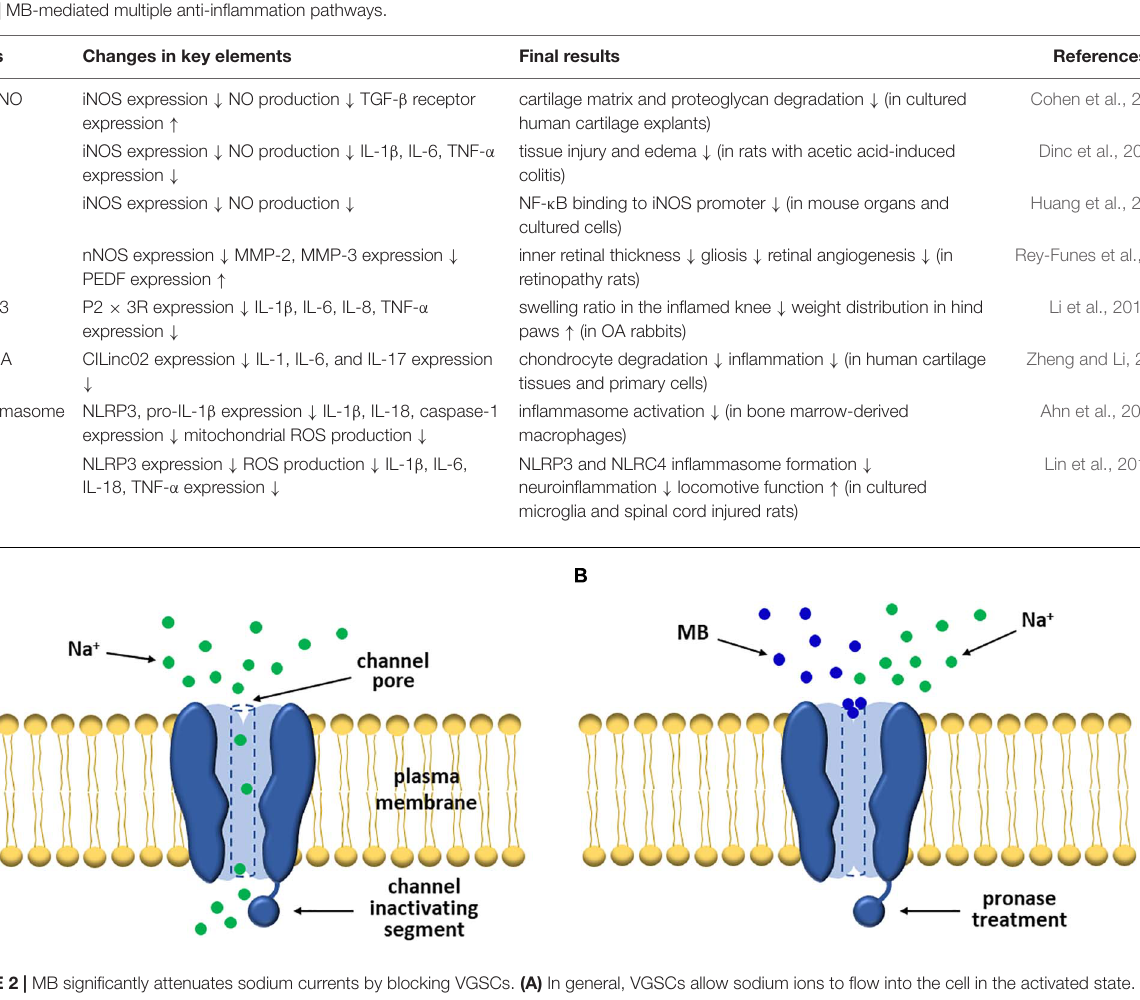
FIGURE 2 | MB significantly attenuates sodium currents by blocking VGSCs. (A) In general, VGSCs allow sodium ions to flow into the cell in the activated state. (B) However, early researchers found that the gate and sodium currents of the channels were markedly suppressed post-MB treatment. And notably, this event was maintained even after pronase treatment. Thus, they interpreted this event as MB functions as a pore blocker rather than an inactivation